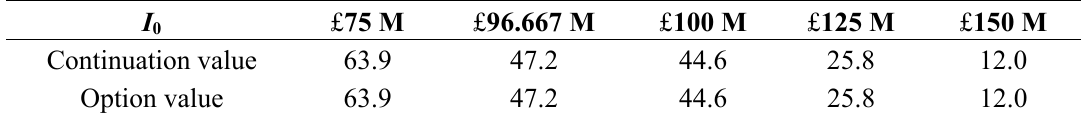
Table 21. Option value (£M) under the electricity price with decreasing